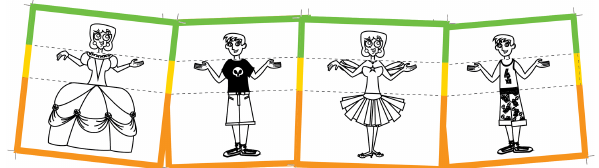
Figure 9. Sketch of some of the available options for characterizing the clothing of the citizens of the Kingdom of Science. From left to right: old-fashioned lab coat (science kingdom), princess dress (his- torical kingdom), kingdom suit, fairy tale dress (fantasy kingdom), music kingdom dress. (Illustrations and graphic project made by Gi- acomo Guccinelli and Lucrezia Benvenuti; Locritani et al., 2015.) Figure 10. Accessories of different characters (illustrations and